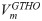
Temporal area plots of changing nadph/nadp+ and gsh/gssg ratios along with change in h2o2 concentration.A. Normal condition, B. Hypoxia, C. Glioma at high VmGTHO(0.19 mM hr-1), D. Glioma at low VmGTHO (0.001 mM hr-1).